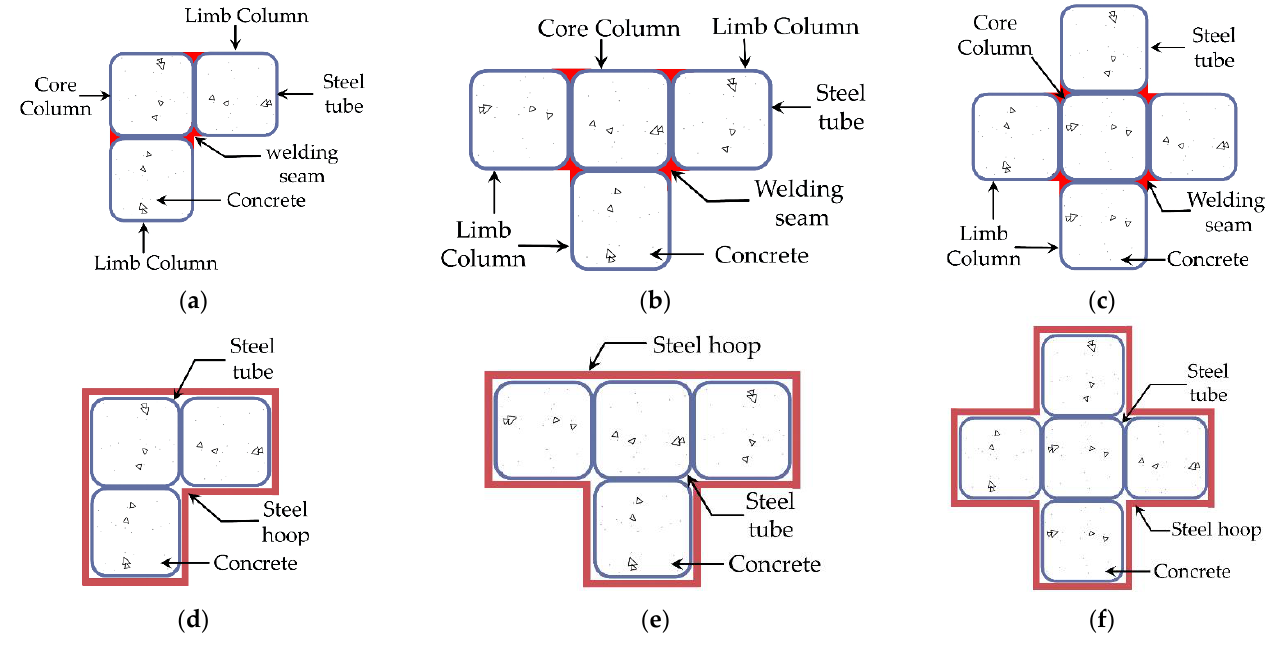
Figure 2. Section diagram of the SS-CFSST composite columns ( a ) weld-type L-shaped; ( b ) weld-type T-shaped; ( c ) weld-type cross-shaped; ( d ) hoop-type L-shaped; ( e ) hoop-type T-shaped; ( f ) hoop-type